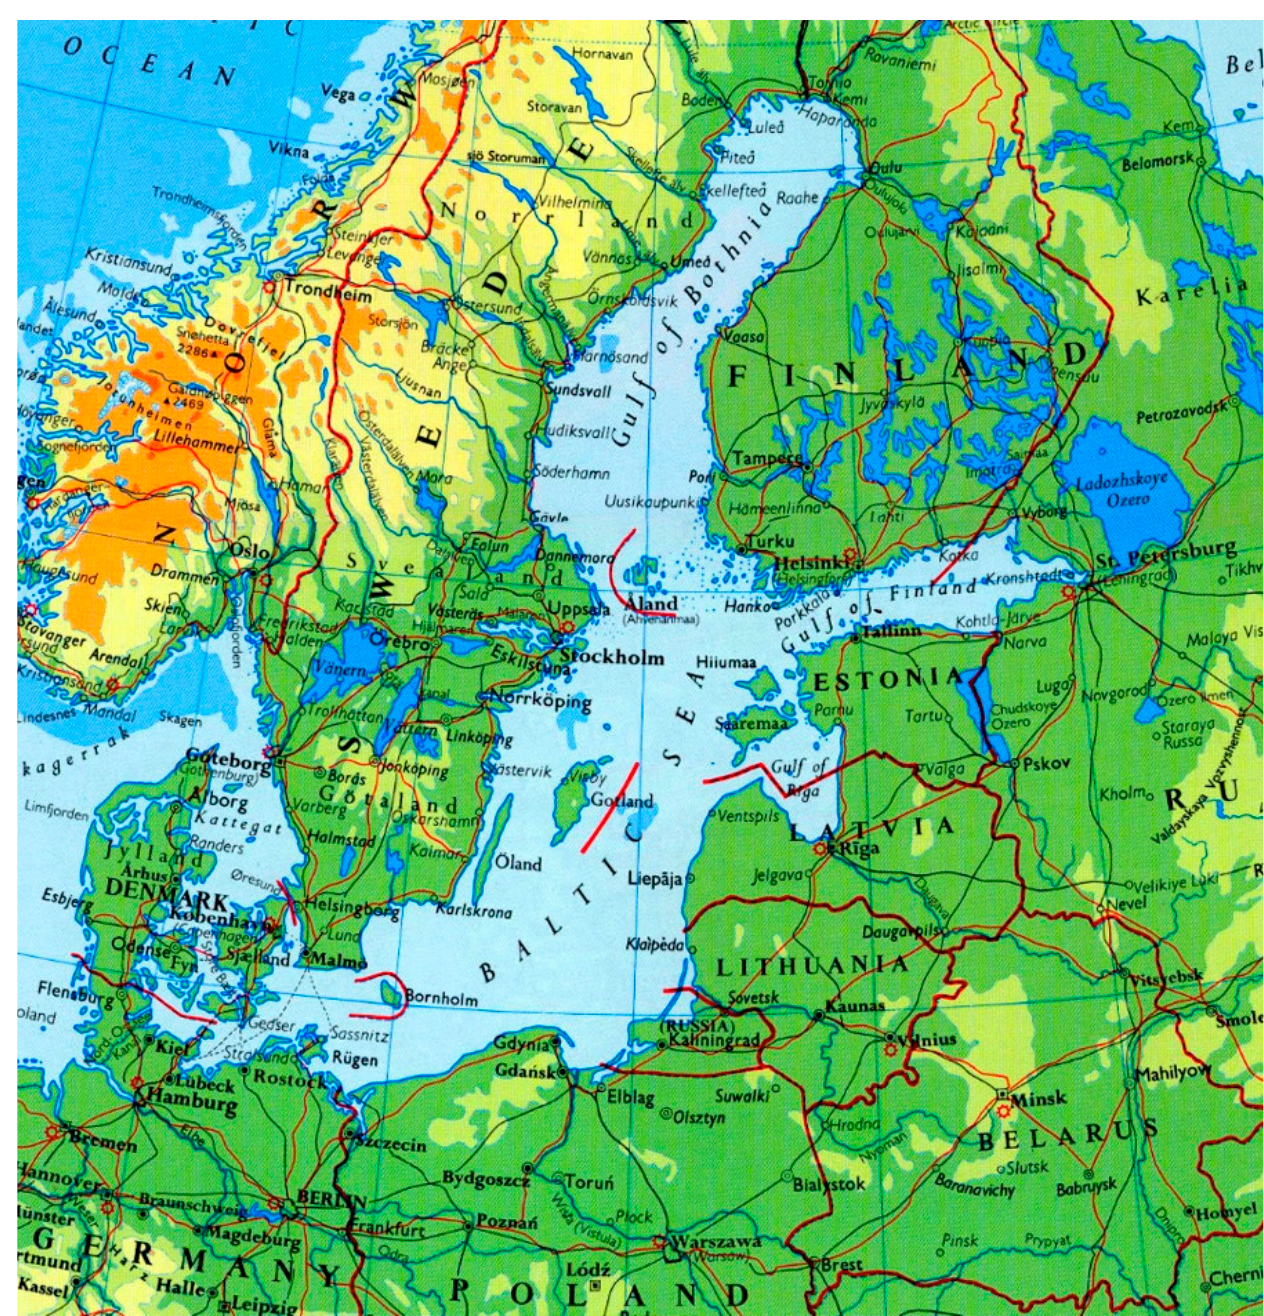
Figure 1. The Baltic Sea with bordering EU countries: Sweden, Finland, Estonia, Latvia, Lithuania, Poland, Germany, and Denmark (source: On The World Map—Free printable maps, accessed on 13 November 2022).